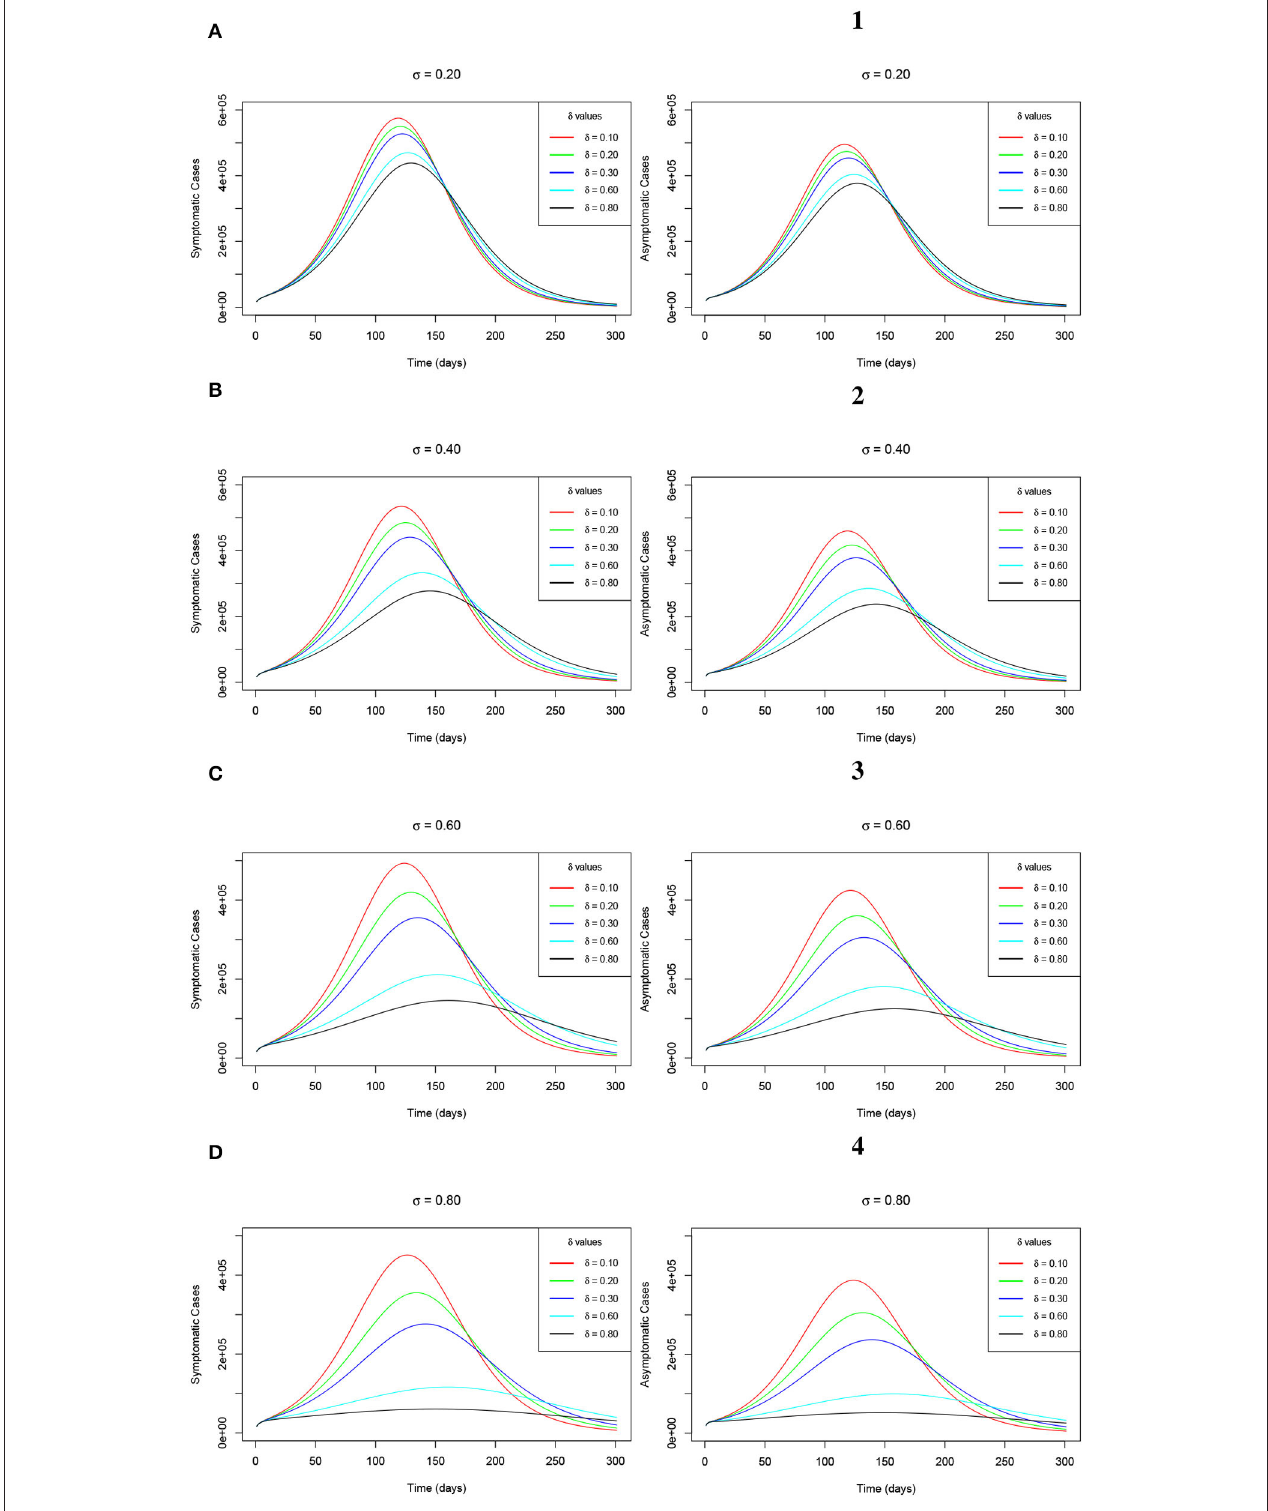
FIGURE 7 | (A–D) Simulations of the model (Equations 2–8) showing the trajectory of the number of symptomatic infections (left-hand-side sub-figures) and the number of asymptomatic infections (right-hand-side sub-figures) as δ varies at changing levels of σ .